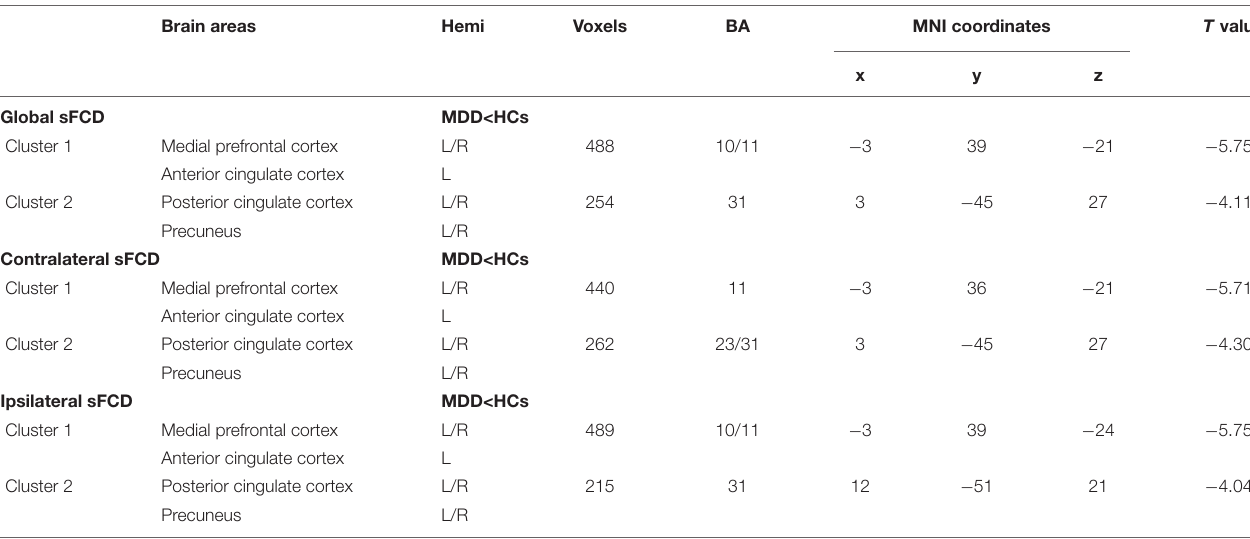
TABLE 3 | Altered global, contralateral, and ipsilateral sFCD in MDD